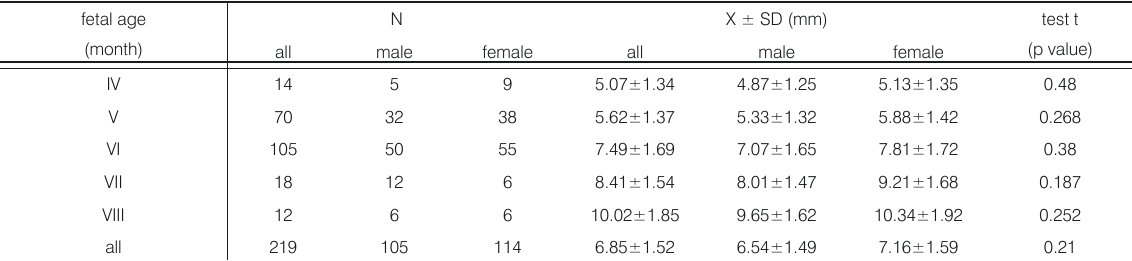
Table 1. Length of coronary sinus between IV-VIII months of prenatal human life. N - number, X – average, SD – standard deviation, test t-Student show gender differences.